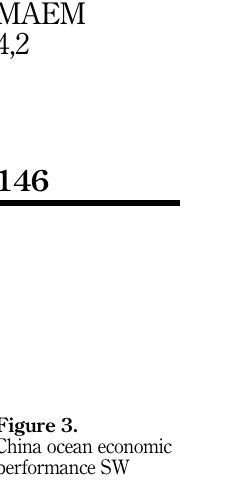
2002002 2004004 2006006 2008008 2010010 2012012 2014014 2016016 2018018